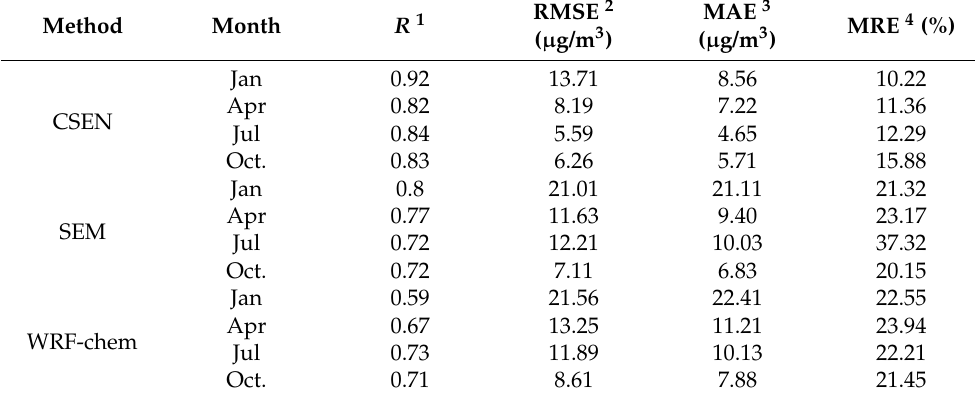
Table 1. Comparison of the CSEN, SEM, and WRF-chem model performance s. Method